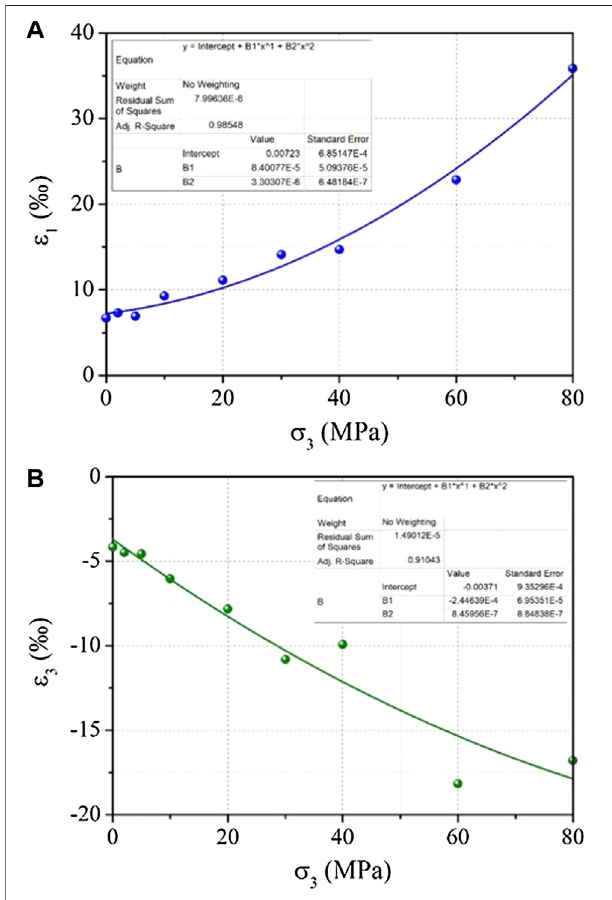
FIGURE 4 | Strain characteristics of the tested samples under conventional triaxial compression state.